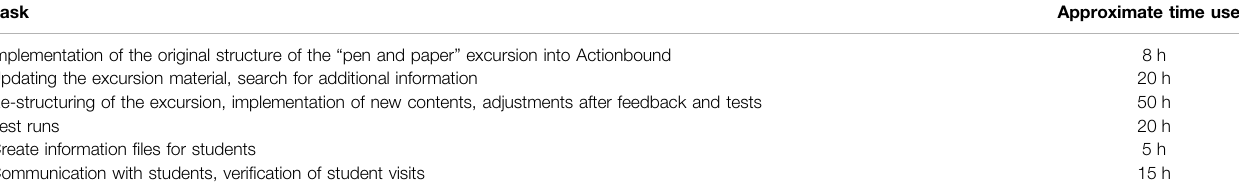
TABLE 4 | Time investment for the development of the smartphone-based self-guided excursion.